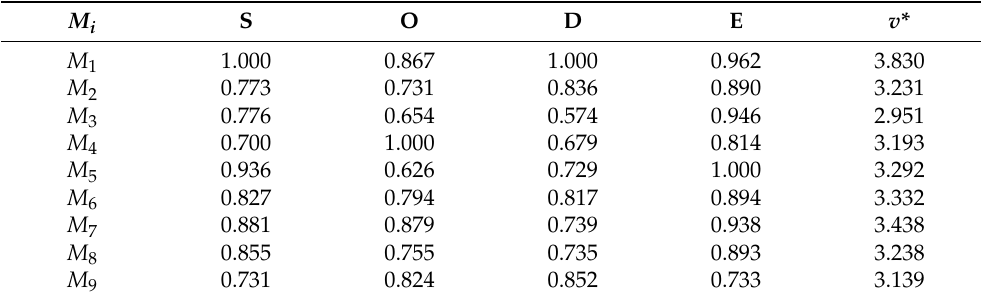
Table 10. The gray correlation coefficient of the failure mode i in relation to the positive ideal solution (PIS).